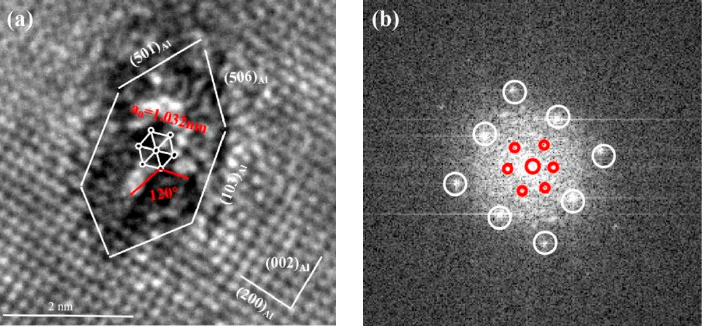
Figure 10. Q ′ phase in A4 alloy after aging treatment along the <010>Al axis: ( a ) HRTEM image, ( b ) corresponding FFT.